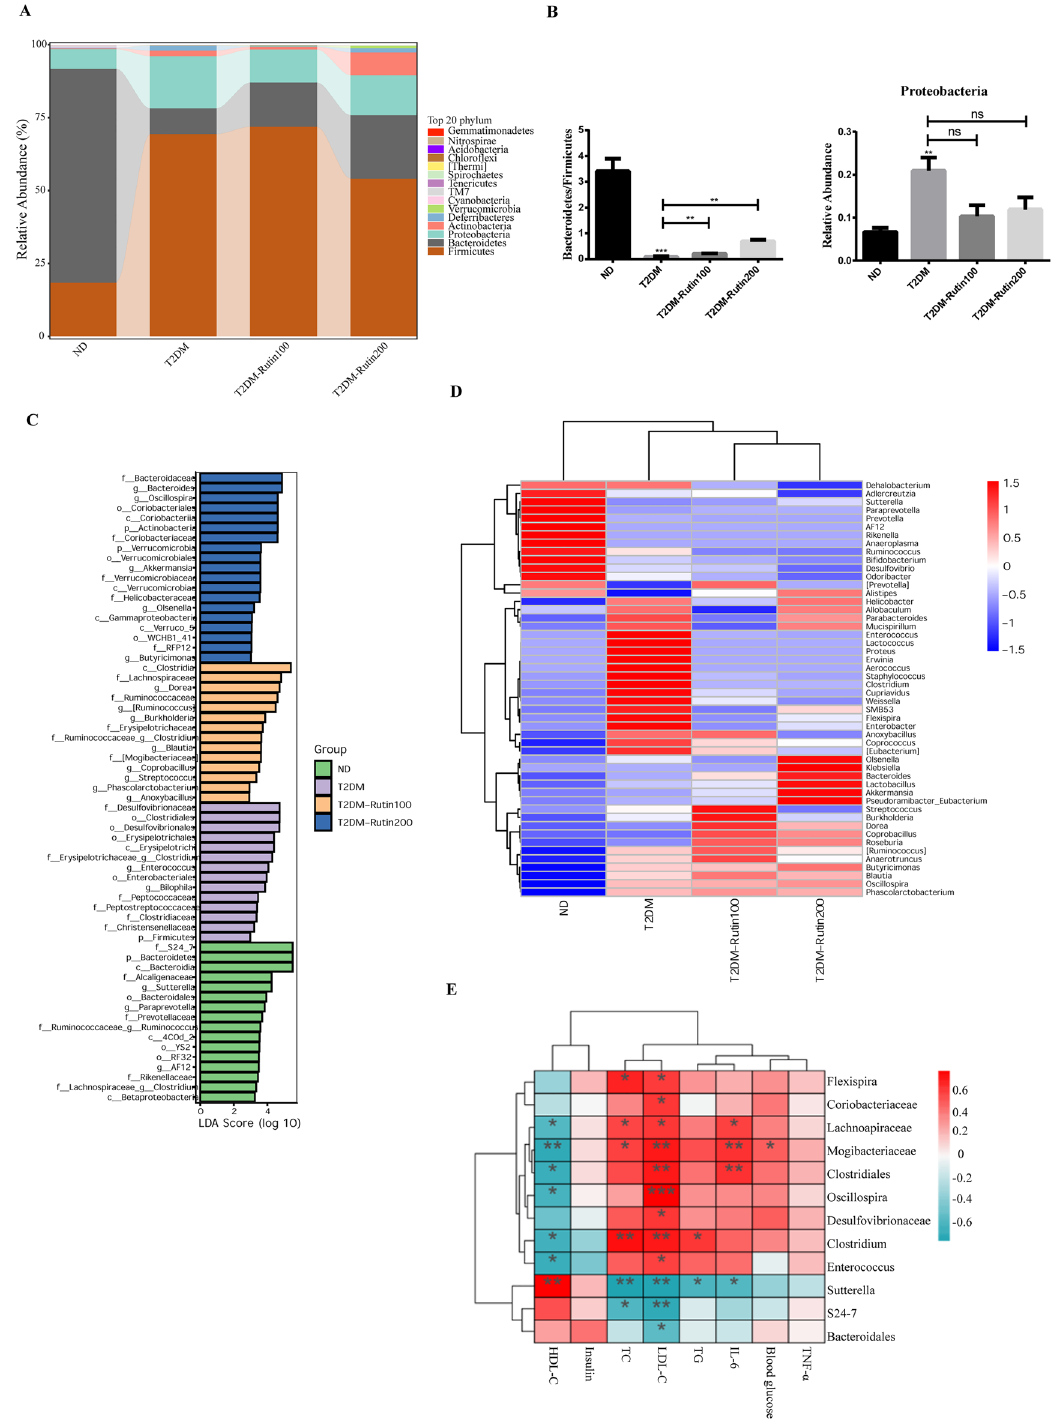
Figure 6. Effects of rutin on the gut microbiota composition in T2DM mice. ( A ) The relative abundances of gut microbiota constituents at the phylum level. ( B ) Bacteroidetes / Firmicutes in feces of mice and relative abundance of Proteobacteria at the phylum level. ( C ) LEfSe analysis of gut microbiota in the ND, T2DM, T2DM-Rutin100, and T2DM-Rutin200 groups, LDA scores > 2 and P < 0. 05 are the taxonomic groups with significant differences between groups. ( D ) Heatmap of the relative abundance of gut microbiota at the genus level. Each column in the plot represents a sample, and each row represents the community structure. The color represents the relative abundance of the species. The heatmap was created using Sangerbox 3.0 (http:// vip. sange rbox. com/). ( E ): Spearman’s correlation analysis of gut microbiota and metabolic parameters. Values are means ± SD (n = 5): *p < 0.05, **p <